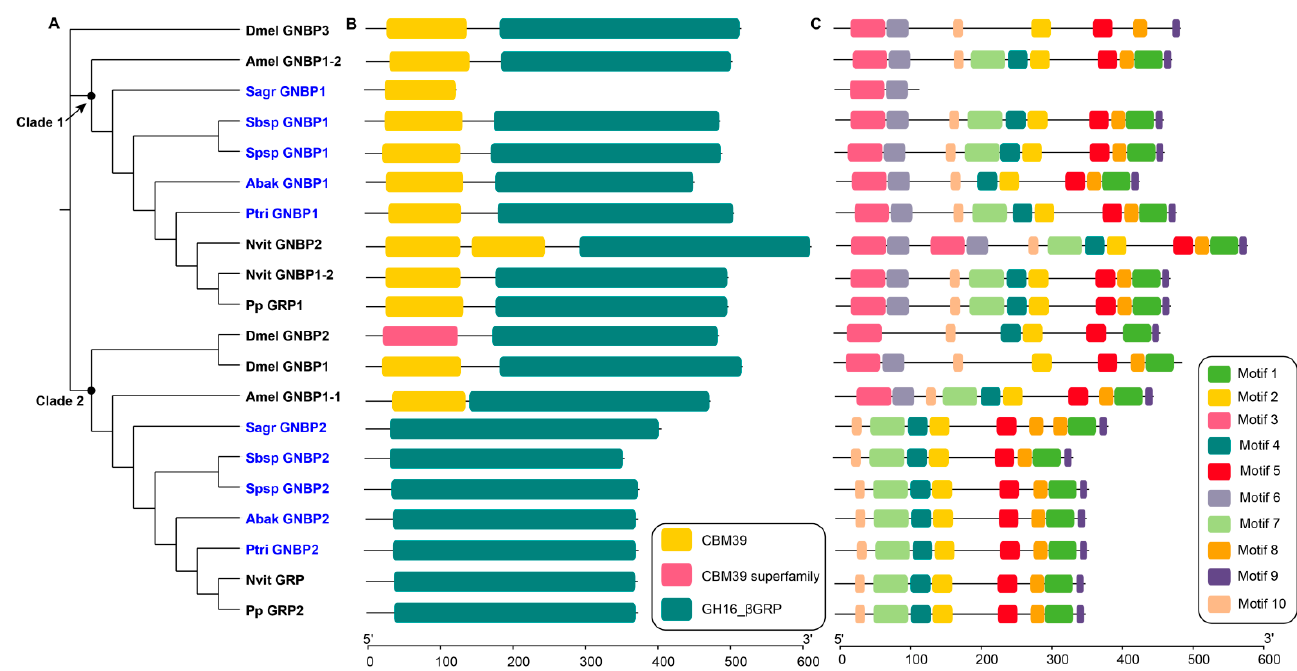
Figure 1. Phylogenetic relationships ( A ), conserved domains ( B ) and motifs ( C ) analysis of GNBPs. The amino acid sequences of GNBPs of five non-pollinators and D. melanogaster (Dmel), A. mellifera (Amel), N. vitripennis (Nvit), P. puparum (Pp) were used to construct the maximum likelihood tree, and the optimal model was LG+I+G4. The non-pollinators were marked with blue, and the four reference species were marked with black.